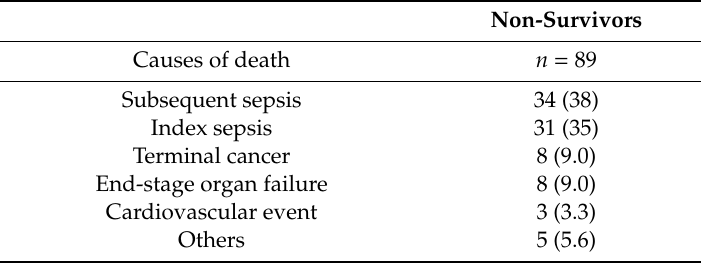
Table 3. Causes of death for the study population.